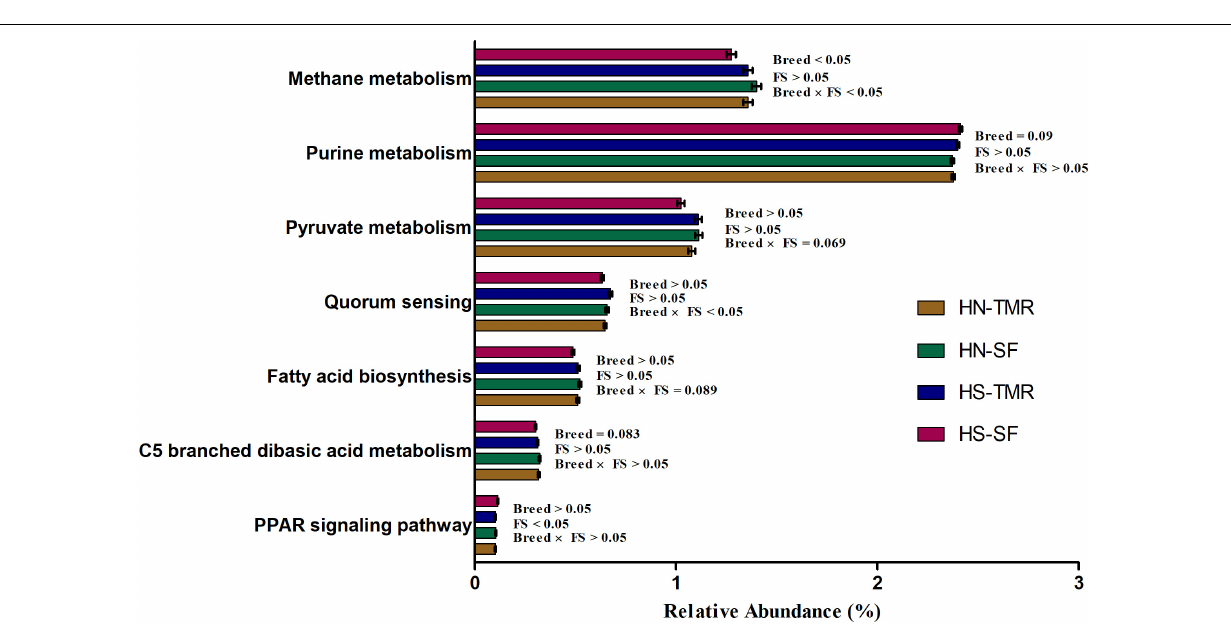
FIGURE 6 | Variations in important rumen microbial Kyoto Encyclopaedia of Genes and Genomes (KEGG) metabolic pathways related to methane emissions in Hanwoo (HN) and Holstein (HS) steers fed a total mixed ration (TMR) or separate feed (SF)